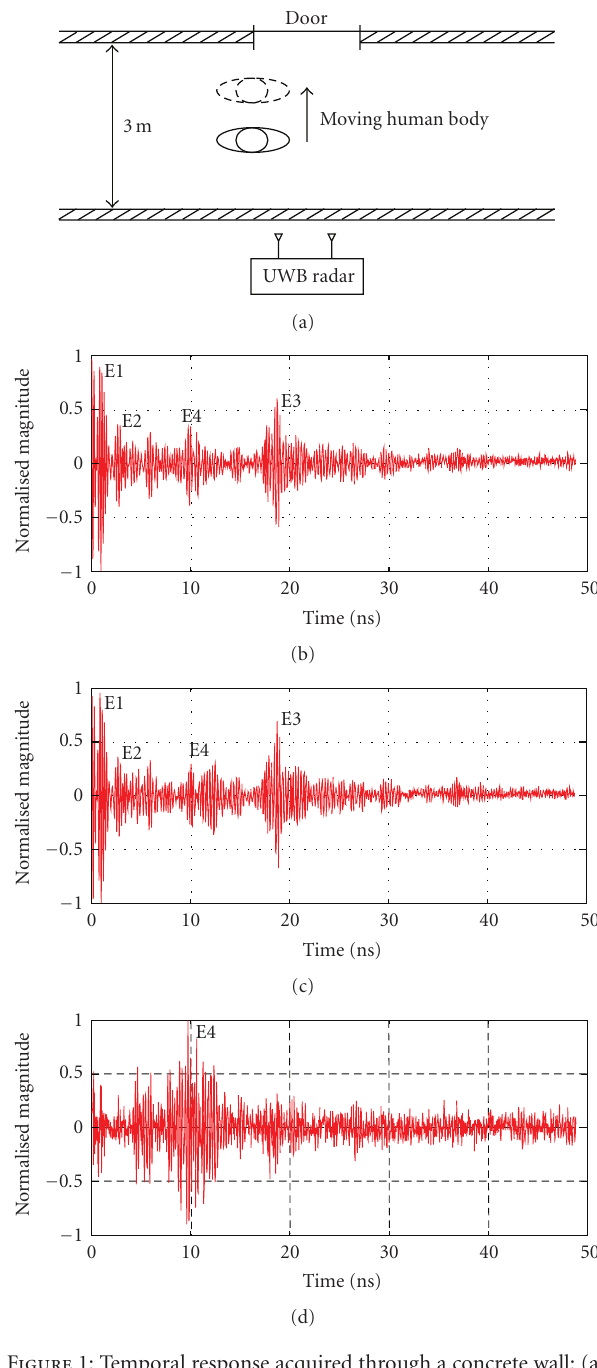
Figure 1: Temporal response acquired through a concrete wall: (a) description of the scene, (b) correspond to an acquisition at t 0 , (c) correspond to an acquisition at t 0 +500 ms, and (d) subtraction between (b) and (c) to clearly identify the “E4” echo corresponding to the moving